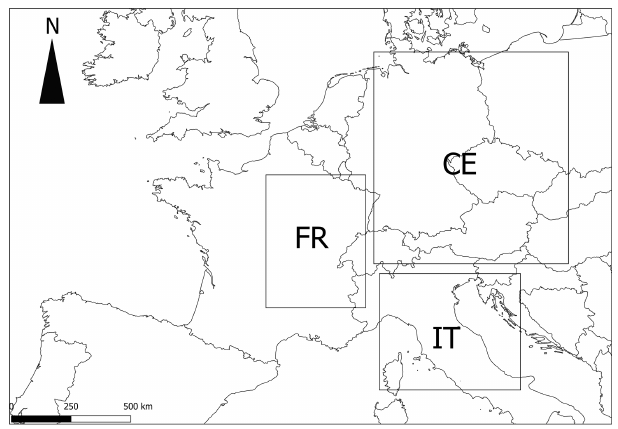
Figure 1. Geographical zones delimited for documentary research (map: Thomas